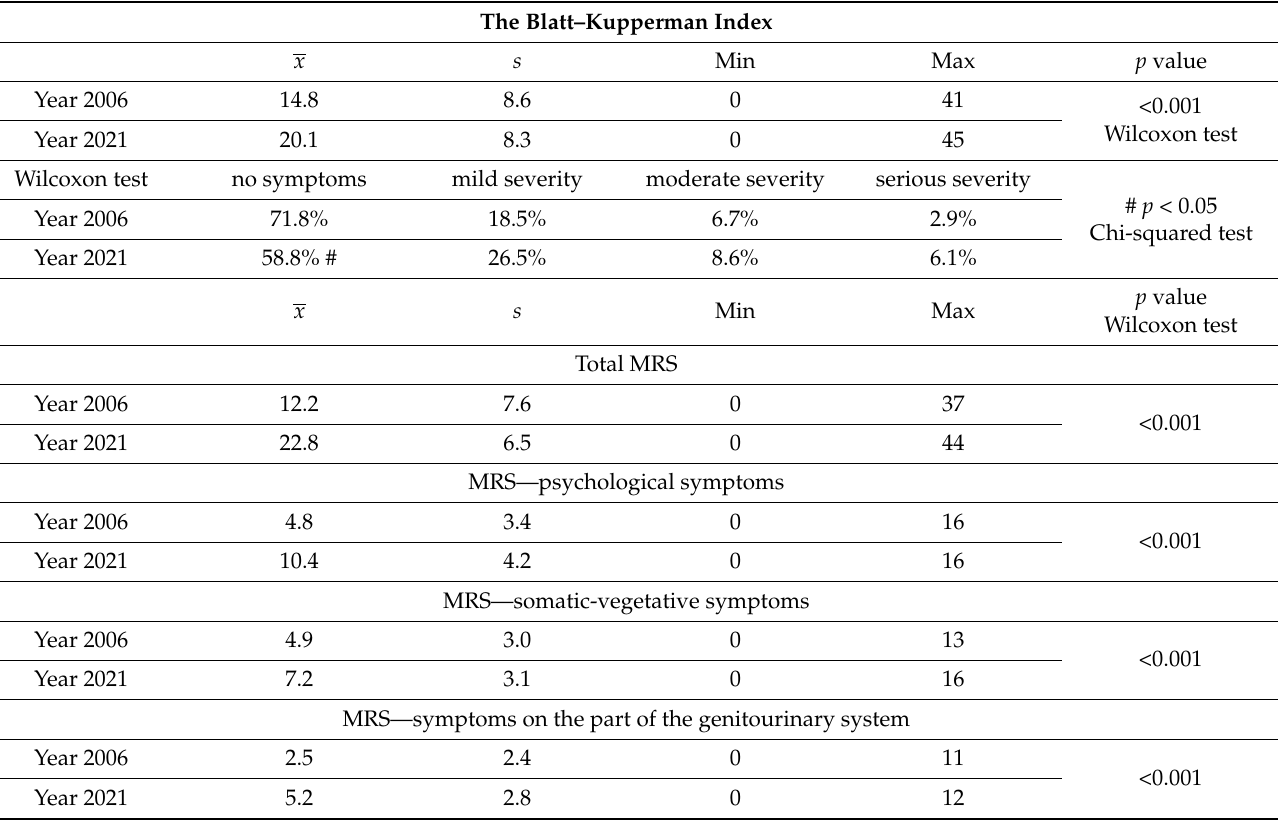
Table 2. The scale of menopausal symptoms in 2006 and